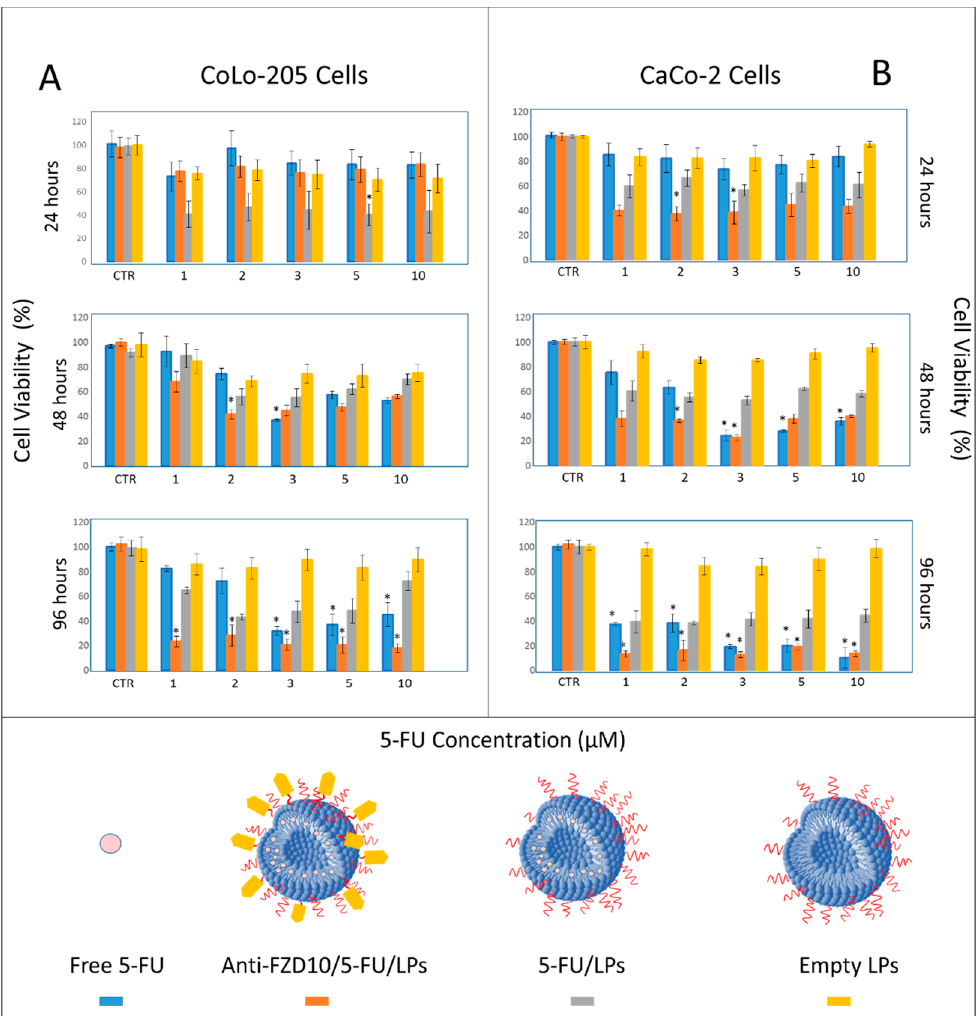
Figure 3. Cell viability, evaluated by MTS cell proliferation assay, of CoLo-205 ( A ) and CaCo-2 ( B ) cells after incubation with free 5-FU, 5-FU/LPs, anti-FZD10/5-FU/LPs and empty LPs at 5-FU concentrations ranging from 1 to 10 µM (from 5 to 50 µM in terms of total lipid concentration) for 24, 48 and 96 h. For each cell line, control was untreated cells. The experiments were conducted in triplicate. (*) p < 0.001 versus control.